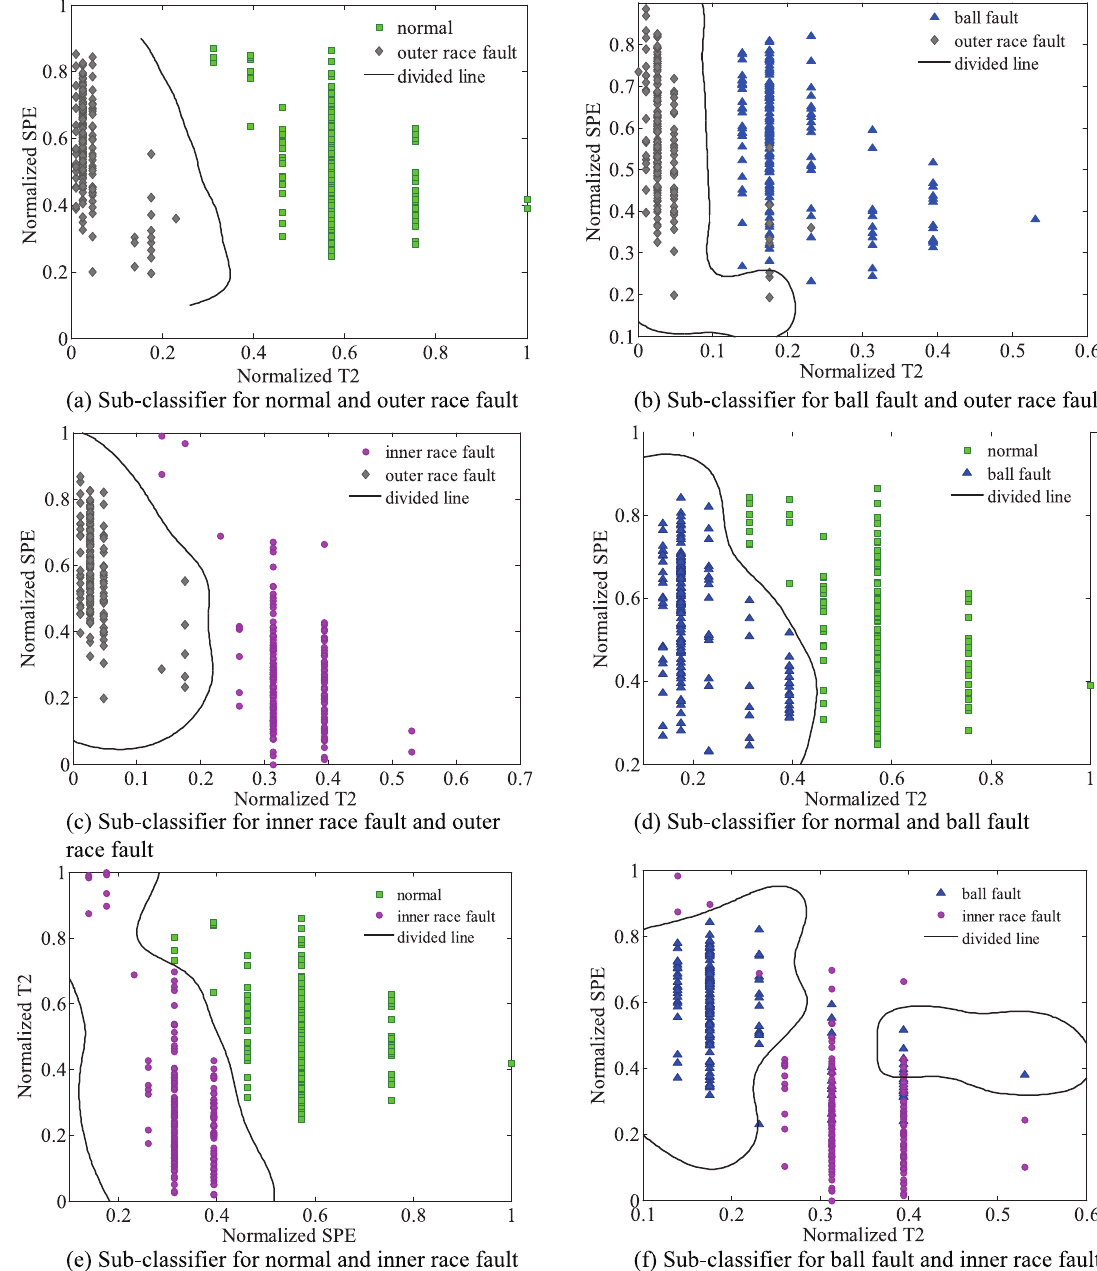
Fig. 7. Classification results of each sub-classifier in multi-class LSSVM in case